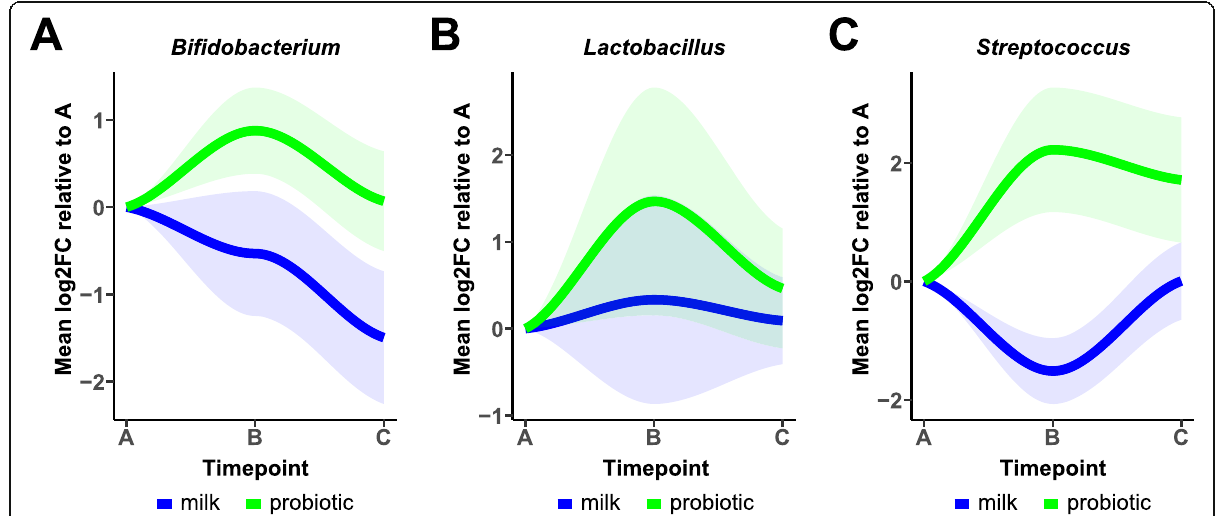
Fig. 2 Change in relative frequency of probiotic organisms over time. The log2 fold change in relative frequency of Bifidobacterium, Lactobacillus, and Streptococcus (panels a , b and c , respectively) relative to timepoint A is plotted over timepoints A, B and C. Average relative frequency in animals treated with probiotics is plotted in green. Average relative frequency in animals treated with milk alone is plotted in blue. Shaded area around the line indicates +/ − one standard error